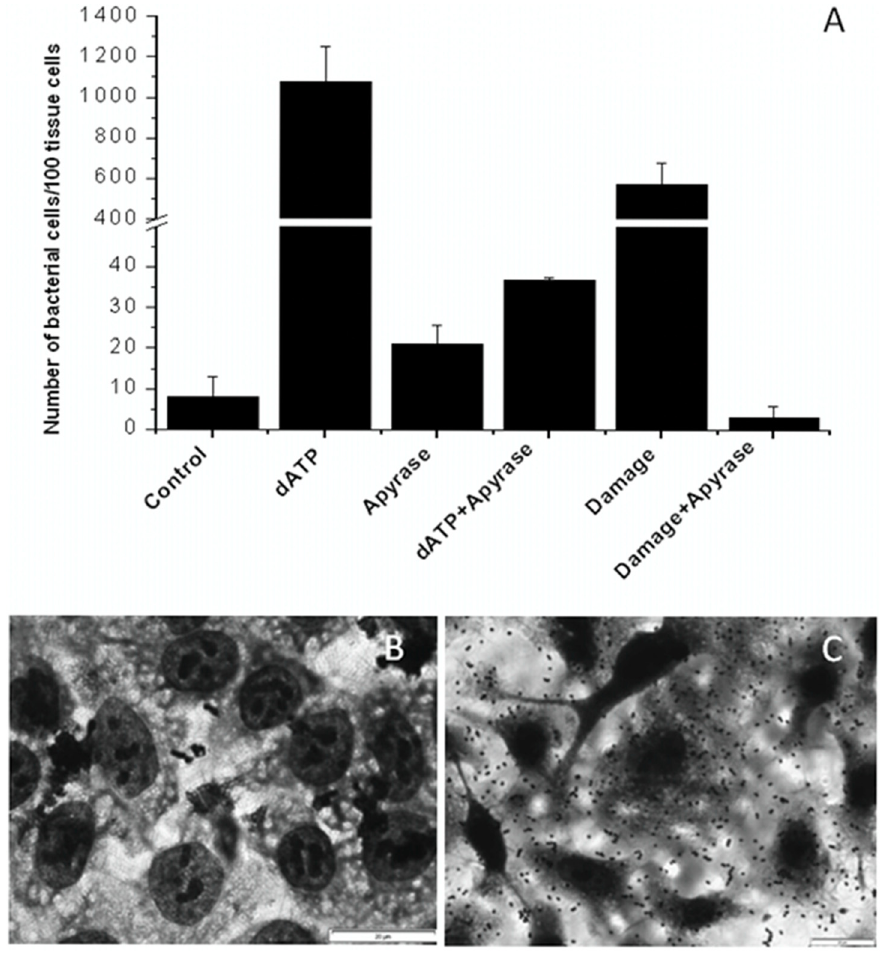
Figure 6. Quantification and light micrographs demonstrating the simulative effect of dATP on adherence of A.baumannii to human bronchial epithelial NCI-H292 cells. A, Number of A. baumannii cells adhered to the monolayer of 100 human bronchial epithelial NCI-H292 cells after 1 hour incubation at 37 u C with 5% (v/v) CO 2 in the RPMI 1640 medium with different treatments: Control (no treatment); dATP (medium supplemented 400 m M of dATP; Apyrase (medium supplemented with 200 mU/ml of Apyrase; Damage (around 5% of a monolayer of the epithelial cells was damaged); and a combination of two treatments. Three independent experiments were performed for each treatment and standard deviations of three treatments were included. B, Representative light micrograph of A. baumannii cells adhered to the epithelial cells after incubation in the RPMI 1640 medium without supplementing dATP;and, C, with supplementing dATP. (Objective 60 6 ).